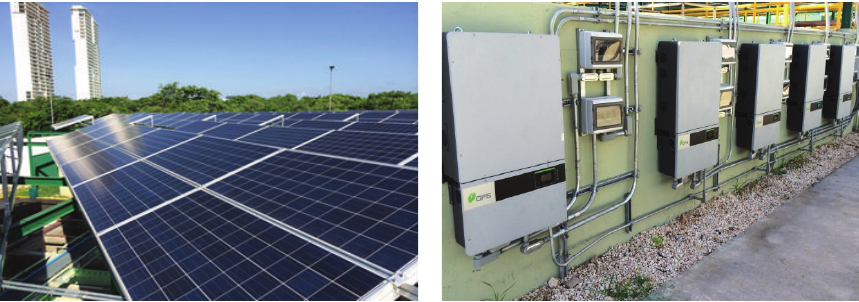
Figure 13: PV facilities of JAPAY in Merida city.